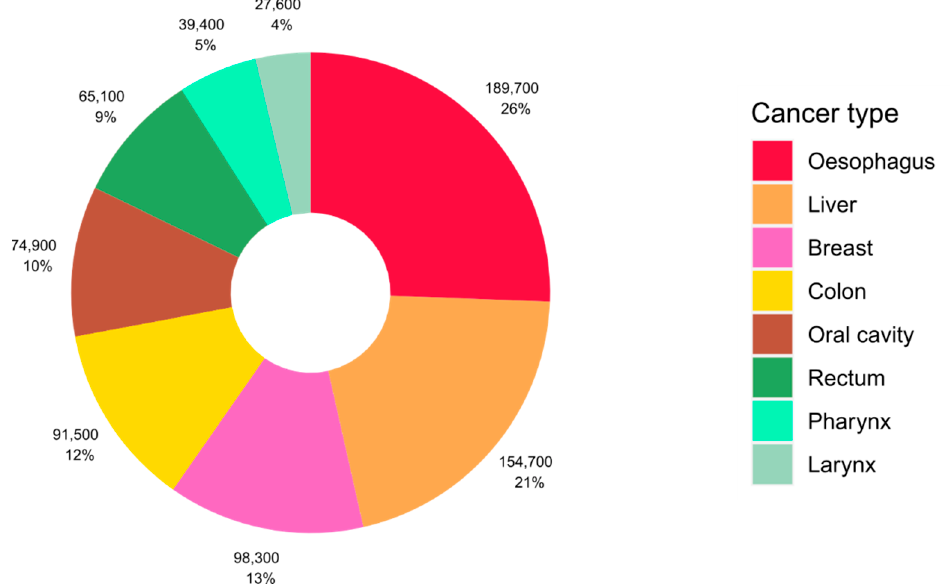
Figure 1. Global number and proportion of cancer cases attributable to alcohol consumption according to cancer type. Source of alcohol-attributable cases: Rumgay and colleagues [1].